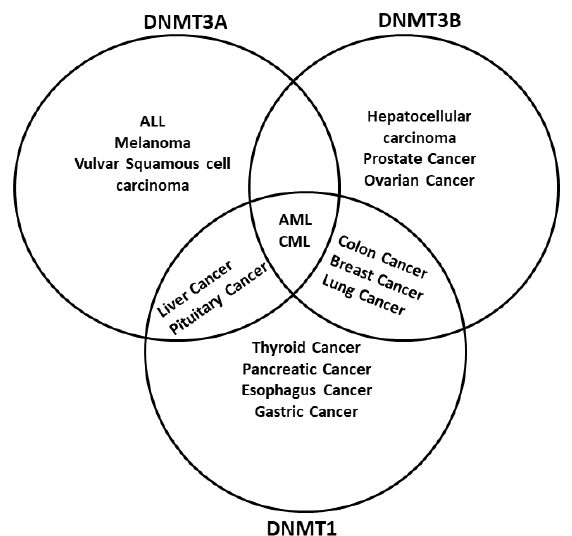
Figure 3. DNA methyltransferases are altered in cancer. DNMTs have a role in genomic regulation. In cancer, DNMTs are affected in expression level. In acute myeloid leukemia (AML) and chronic myeloid leukemia (CML), The three DNMTs are overexpressed. DNMT1 and DNMT3A have been described as affected in liver cancer and pituitary cancer, while DNMT1 and DNMT3B are overexpressed in breast cancer, colon cancer, and lung cancer; DNMT3B is deregulated in colon cancer and prostate cancer, and DNMT1 is deregulated in the pancreas cancer and esophagus cancer. In other cases, only one DNMT is overexpressed; however, only one DNMT could be enough to result in cancer development, progression, and metastasis. Abbreviatures: Myelodysplastic syndrome (MDS), chronic myelomonocytic leukemia (CMML), acute lymphoblastic leukemia (ALL), melanoma.